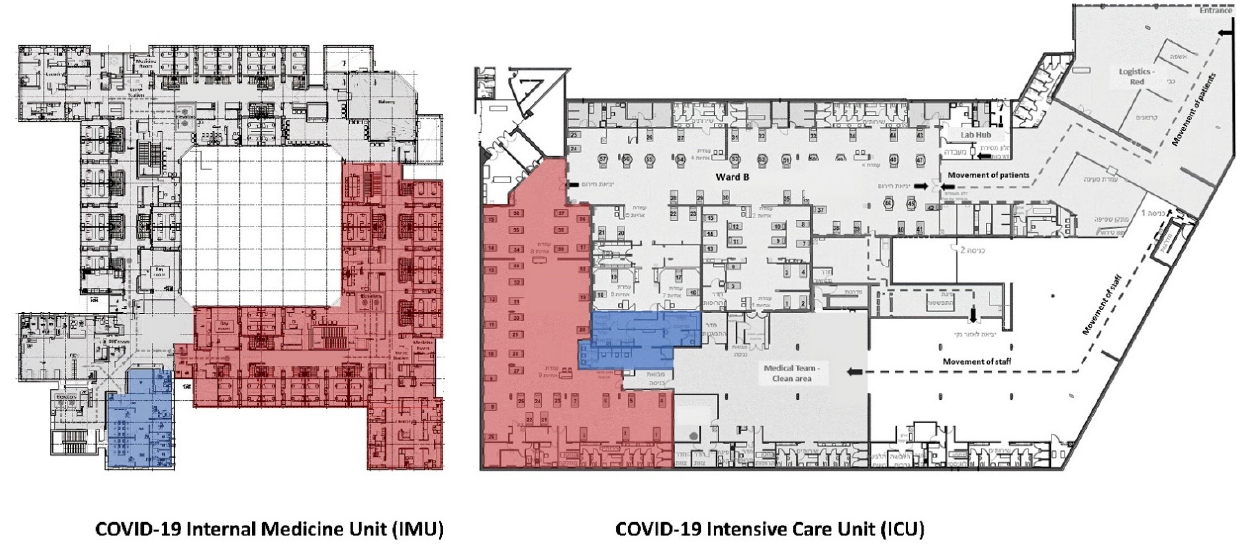
Figure 1. Architectural plans of the COVID-19 IMU ( left ) and the COVID-19 ICU ( right ) illustrating the clinical contaminated zone (in red) and the control room in the clean zone (in blue).